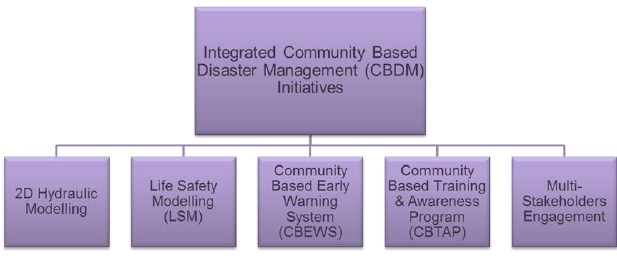
Figure 1: Integrated Community Based Disaster Management Initiative